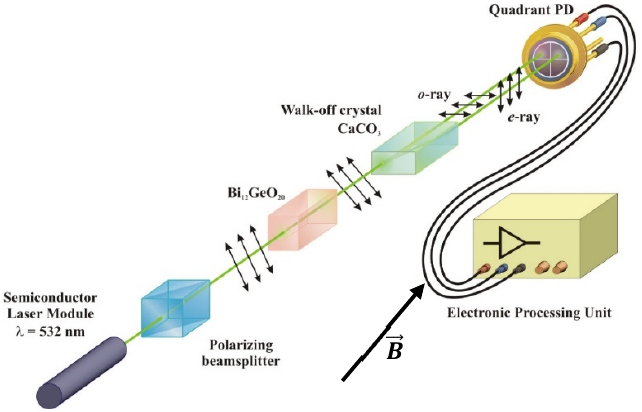
Figure 3. Free-space setup for Faraday angle measurement by the ∆ Σ normalization method. The plane of polarization of light after FMs in the absence of the field is set to ±45° in respect to the fast and slow axes of birefringent crystal. Orthogonal polarizations are spatially separated by birefringent crystals, and both depend on light source power in the same way. After transimpedance stages the voltages of the two channels are: